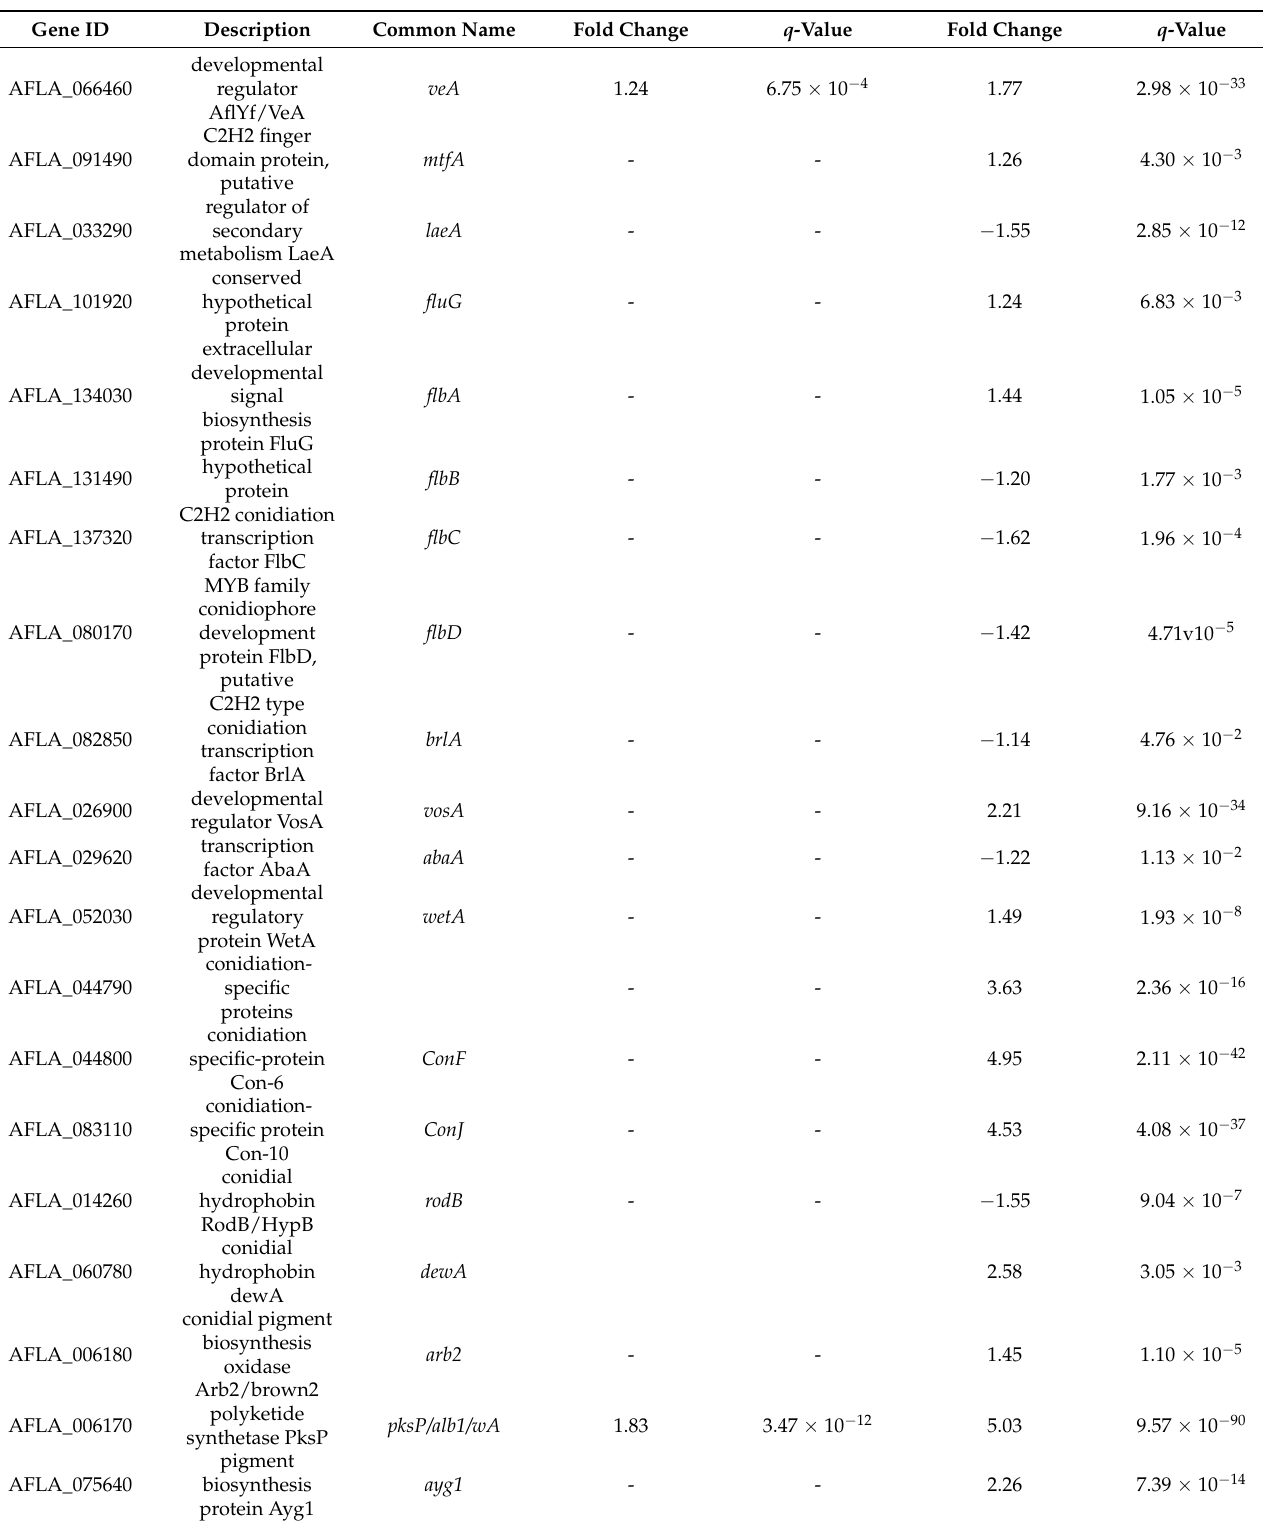
Table 1. Differentially expressed genes related to the fungal development in Aspergillus flavus . Fold changes for under- expressed genes are marked in bold